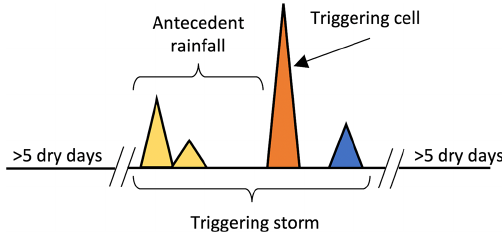
Figure 5. Schematic representation of the triggering storms show- ing triggering storm, triggering cell and antecedent rainfall. The col- ored triangles represent the rainfall throughout the triggering storm: antecedent rainfall (yellow), triggering cell (orange) and rainfall af- ter the DF triggering in